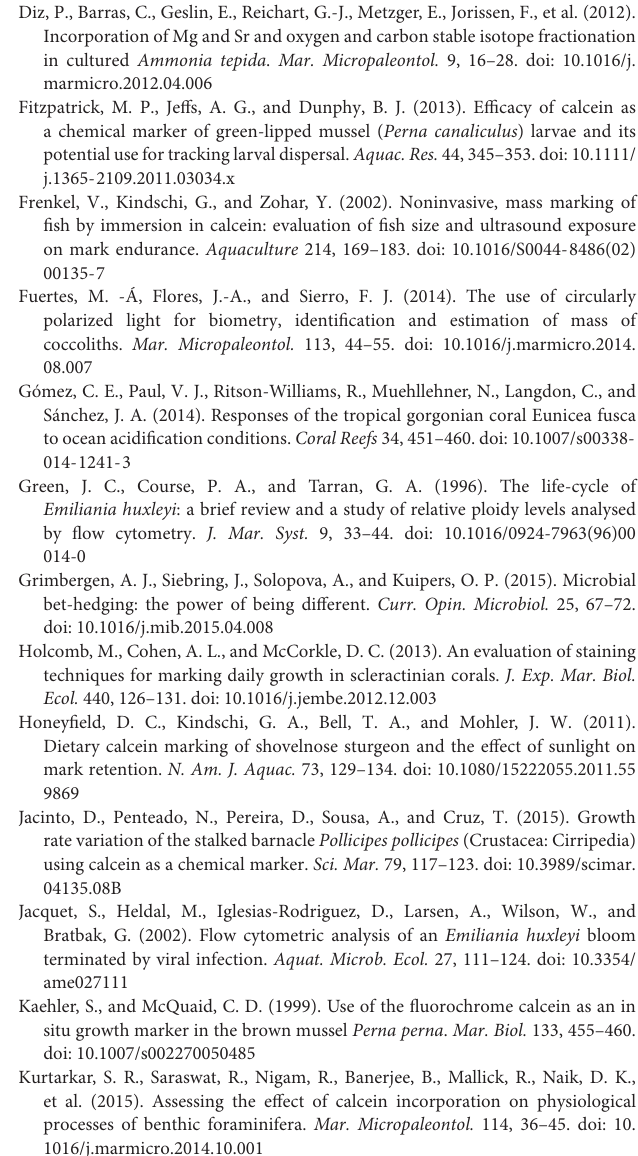
FIGURE S2 | Flow cytometry of coccoliths. Forward scatter (FSC, proxy for cell size) versus side scatter (granularity), chlorophyll, and calcein for a mixed population of unstained E. huxleyi (94%) cells and S. apsteinii ( ∼ 6%) cells. The side scatter signal is characteristic of coccolithophores due to their calcite coccosphere. The two very different sized coccolithophore species were readily distinguished. The signal in the calcein channel for each species is likely due to autofluorescence of photopigments that are not excluded by the FITC filterset. FIGURE S3 | Flow cytometry of a mixed population of E. huxleyi . Forward scatter (FSC, proxy for cell size) versus side scatter (granularity), chlorophyll, and calcein for a mixed population of unstained (46.6% of events) and unstained (38.1% of events) E. huxleyi cells. The mixed sample is described by a single population in the SSC and chlorophyll plots, whereas discrete populations of stained and unstained cells are detected in the calcein